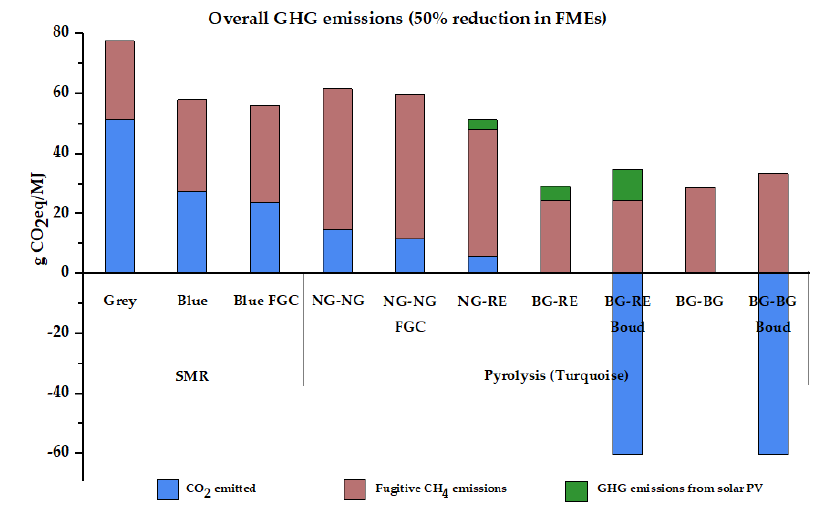
Figure 11. The overall GHG emissions for grey, blue, and turquoise hydrogen production after 50% reduction in FMEs.